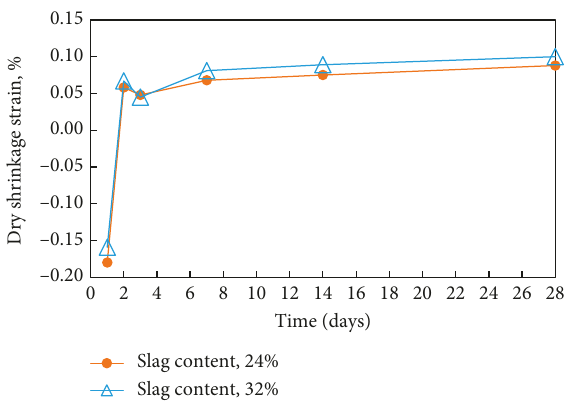
Figure 16: Dry shrinkage strain for